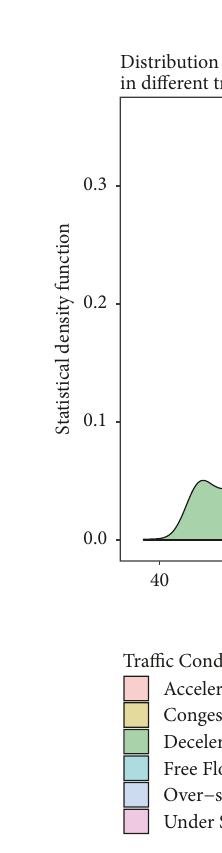
Figure 7: Comparing the distributions of noise level at receiver in different traffic